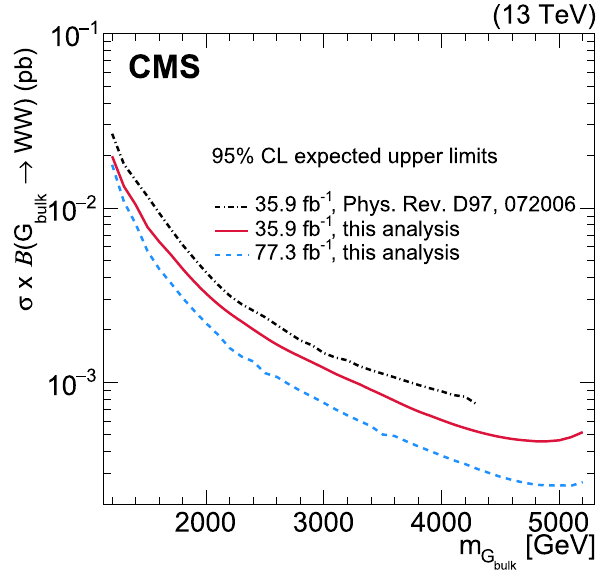
Fig. 13 Expected 95% CL upper limits on the product of the produc- tion cross section ( σ ) and the branching fraction for a G bulk → WW signalusing35.9fb − 1 ofdatacollectedin2016obtainedusingthemulti- dimensional fit method presented here (red solid line), compared to the result obtained with previous methods (black dash-dotted line) [29]. The final limit obtained when combining data collected in 2016 and 2017 is also shown (blue dashed